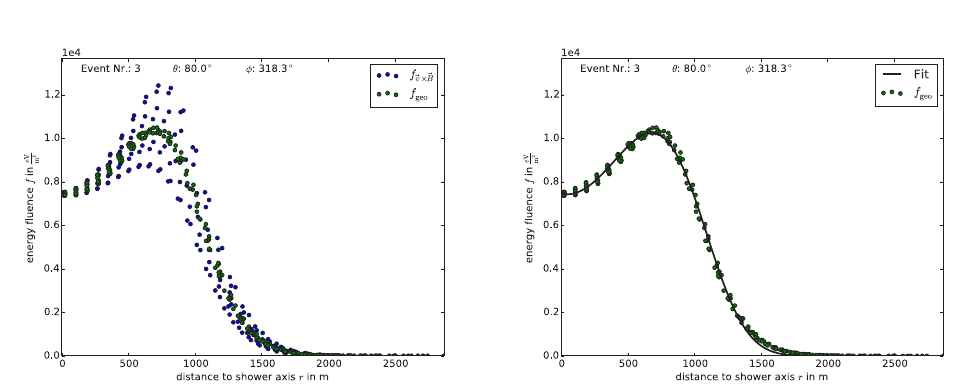
Figure 2. Left: Distribution of energy fluences before (blue) and after (green) symmetrization through deduction of the charge-excess component. Right: Illustration of the LDF fit with equation Eq.